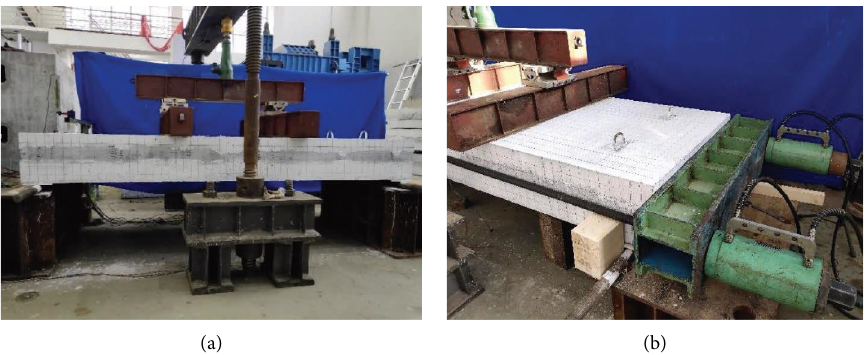
Figure 4: Test set-up. (a) Four-point fexural test and (b) axial loading